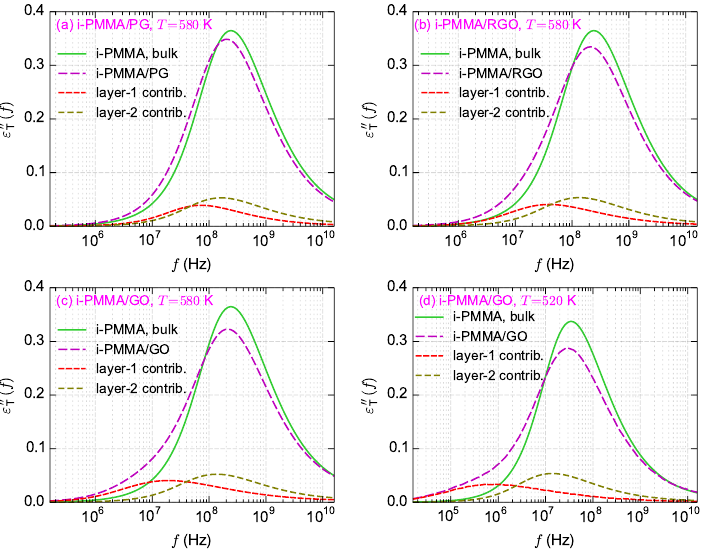
Figure 11: The loss parts of the backbone torsional autocorrelation functions. ( a – c ) The results for i-PMMA/PG, i-PMMA/RGO, and i-PMMA/GO systems at T = 580 K, and ( d ) the results for i-PMMA/GO system at T = 520 K. In all panels, the ε 00 ( f ) for the bulk and confined melts, and the contributions of the first and second interfacial layers in the ε 00 ( f ) of the confined melts, are shown. These curves in the time domain are presented in Figures 3 and 10.